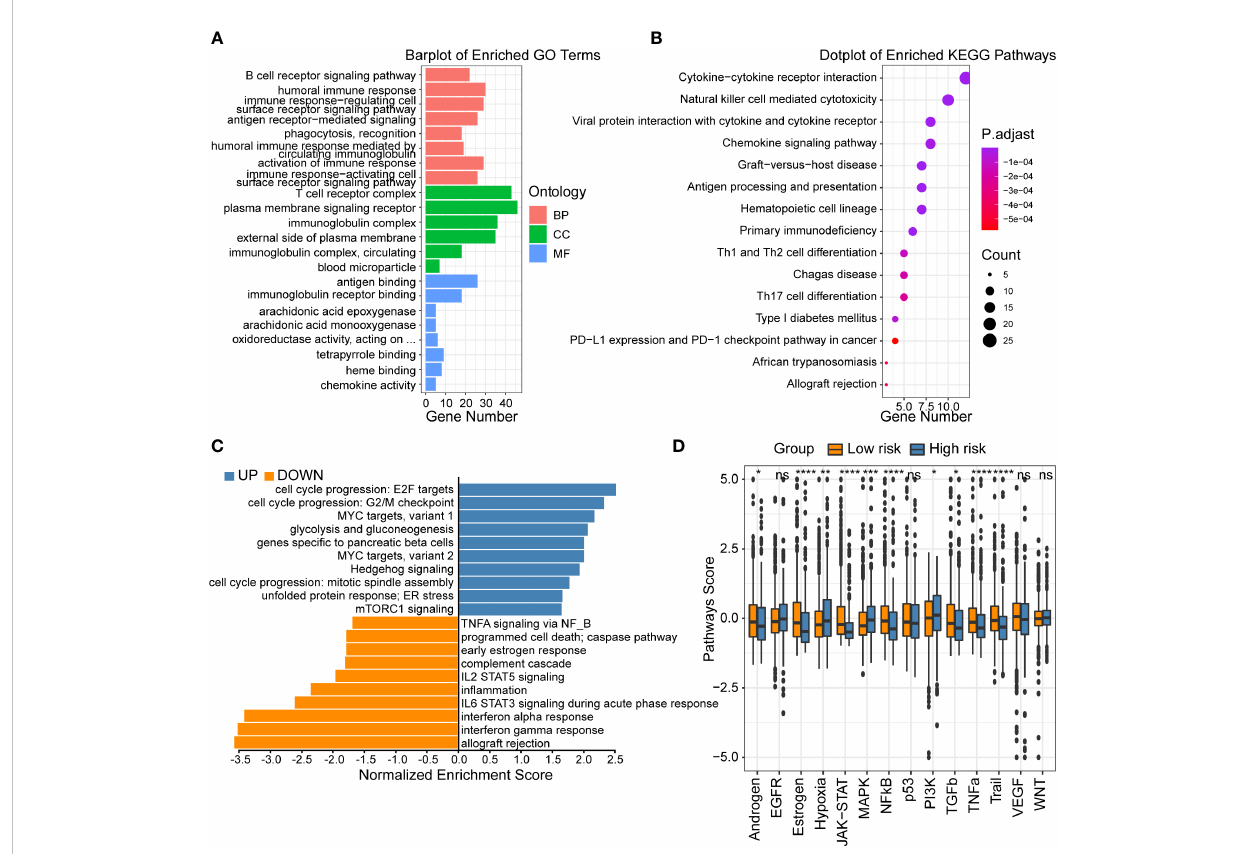
FIGURE 3 Functional analysis of centrosome-related prognostic model. (A) GO enrichment of centrosome-related DEGs in low-risk subgroups. (B) KEGG pathways of centrosome-related DEGs in low-risk subgroups. (C) Gene set enrichment analysis (GSEA) of centrosome-related prognostic model. (D) Analysis of 14 cancer-related pathway activities score. The asterisks represent the statistical P value (*p < 0.05; **p < 0.01; ***p < .001; ****p < 0.0001; ns p >